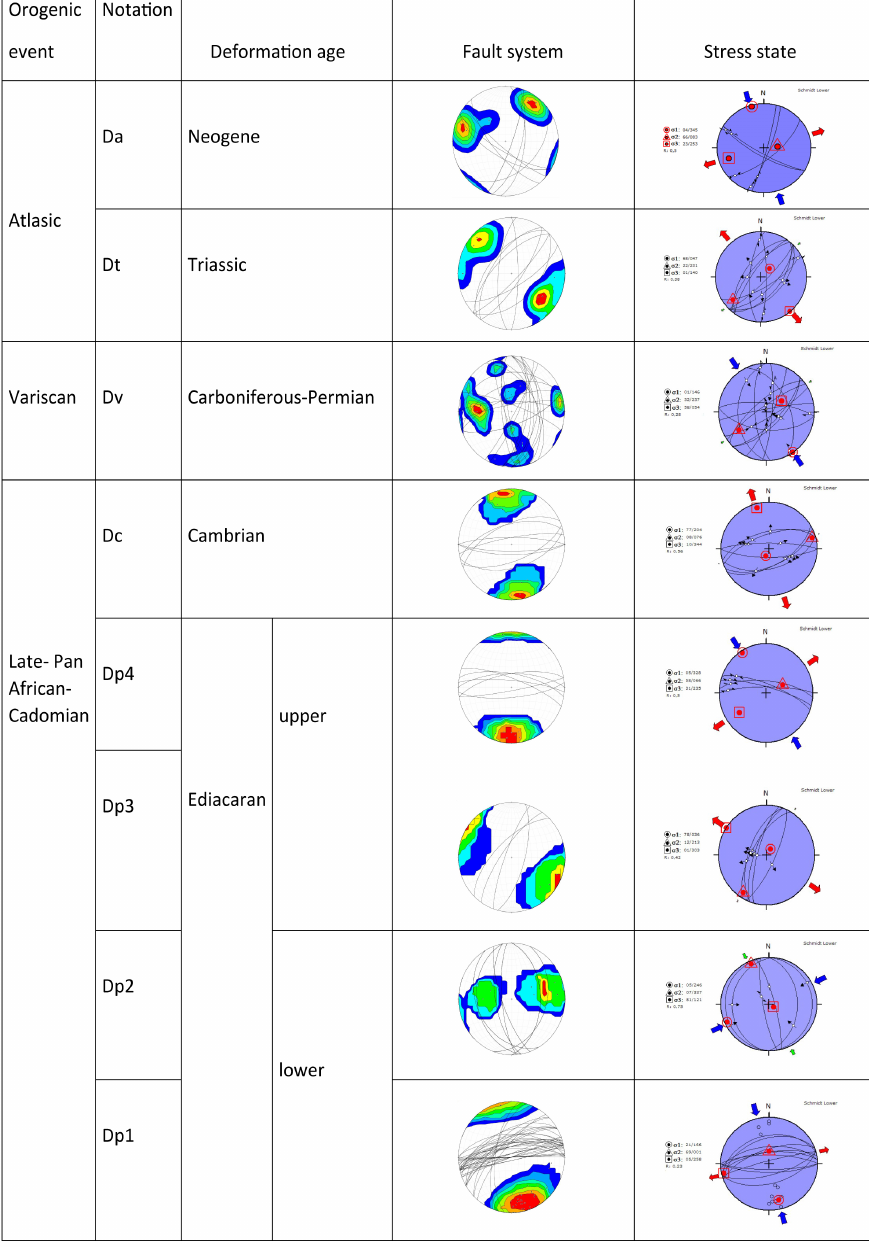
Figure 12. Comprehensive figure of fault system and paleostress evolution of major orogen affecting the Imiter area.